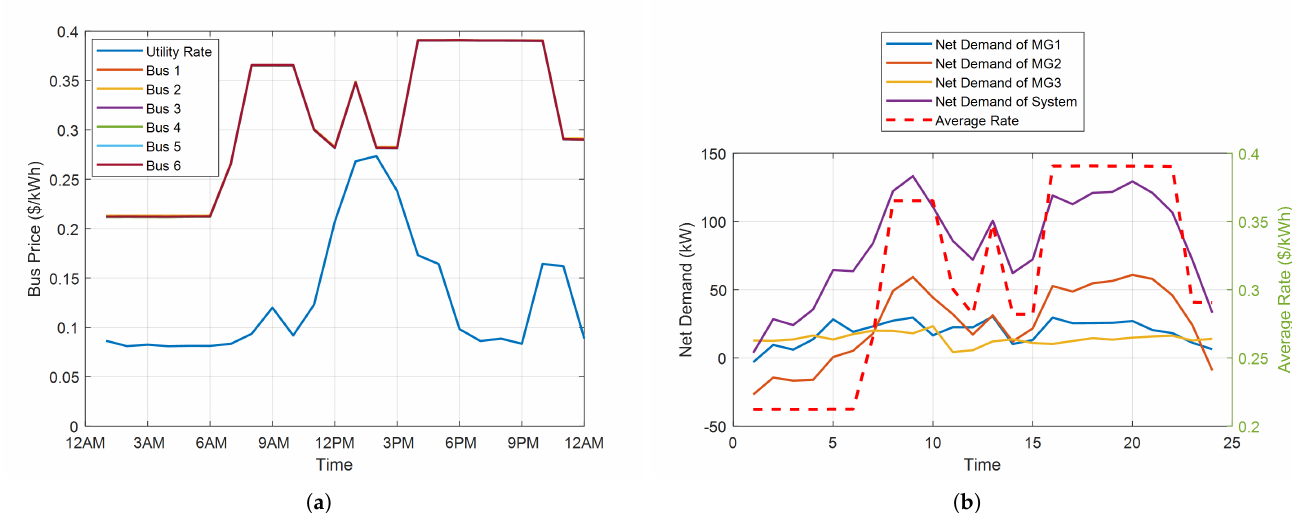
Figure 10. Calculated bus prices and system net demands in islanded mode. ( a ) Bus Price. ( b ) System Net